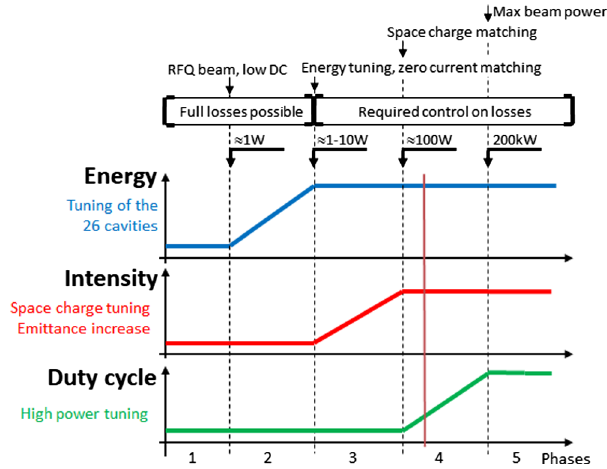
FIG. 3. Phases of the beam power ramp-up for the SPIRAL2 SC linac